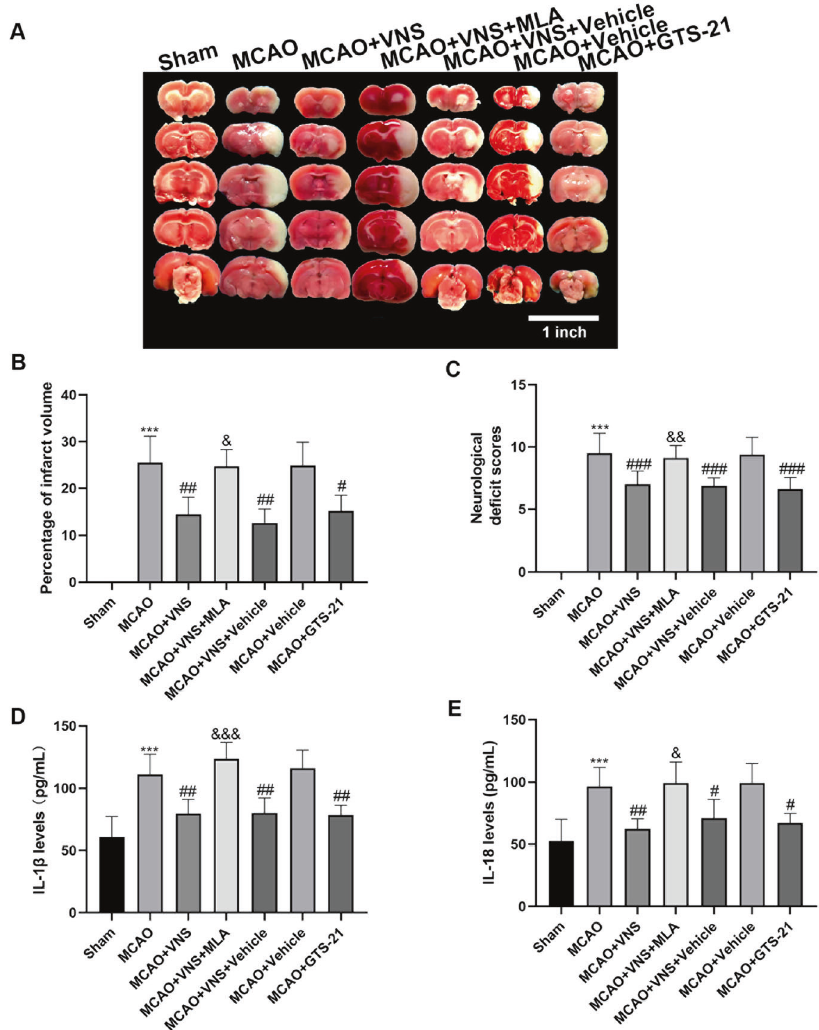
Fig. 6 The neurological protection and anti-in fl ammatory effects of VNS were α 7nAchR-dependent. A , B Representative 2,3,5-triphenyl tetrazolium chloride staining images at 3 days following ischemia/reperfusion injury and quantitative analysis of infarct volumes ( n = 6 per group). C Assessment of the neurological scores in each group ( n = 8 in each group). D , E Representative enzyme-linked immunosorbent assays of pyroptosis-related pro-in fl ammatory factors IL-1 β and IL-18 (n = 6 in each group). * P < 0.05, ** P < 0.01, *** P < 0.001 versus the